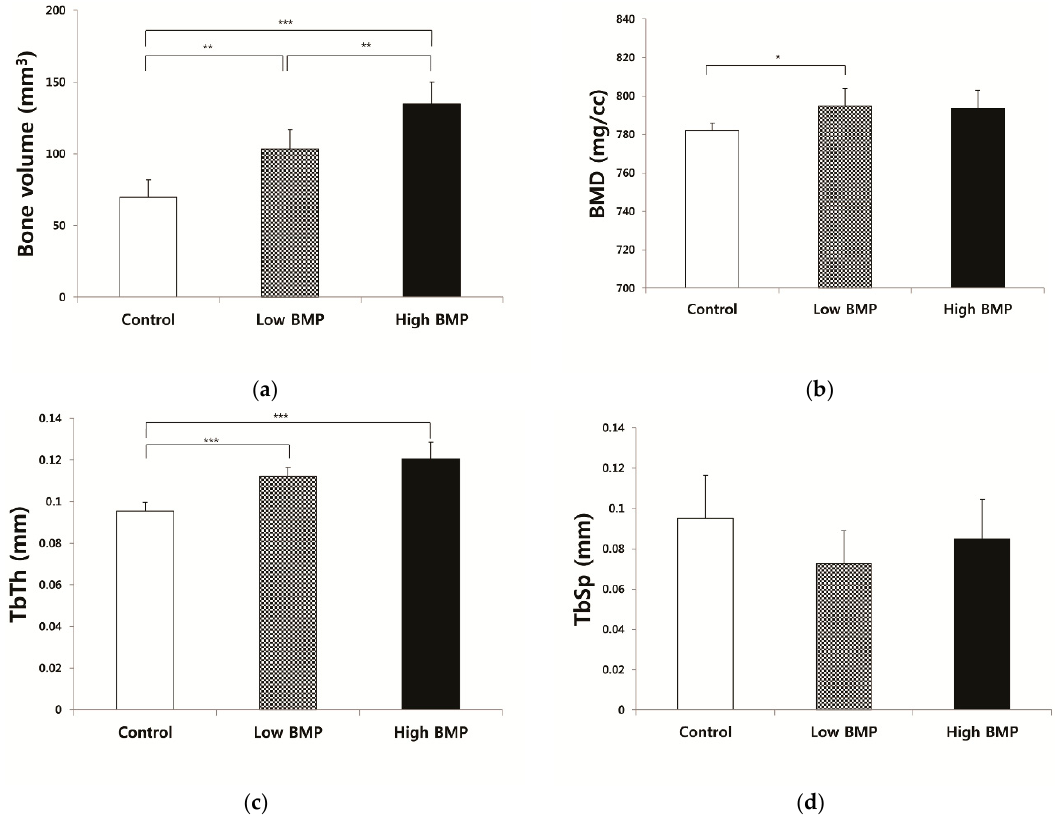
Figure 3. µ-CT analysis at 6 weeks after operation. ( a ) Bone volume, ( b ) bone mineral density, ( c ) trabecular thickness, and ( d ) trabecular spacing of the control (ABB: anorganic bovine bone), low BMP (ABB + 5 µg of rhBMP-2), and high BMP (ABB + 50 µg of rhBMP-2) group (** p < 0.05, *** p < 0.001).